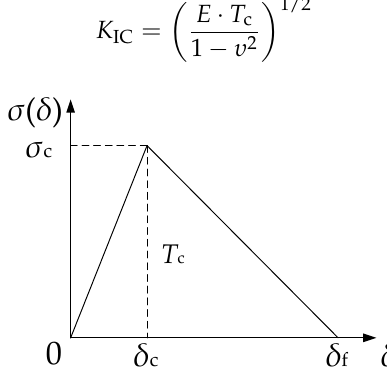
Figure 2. The bilinear cohesive zone model.